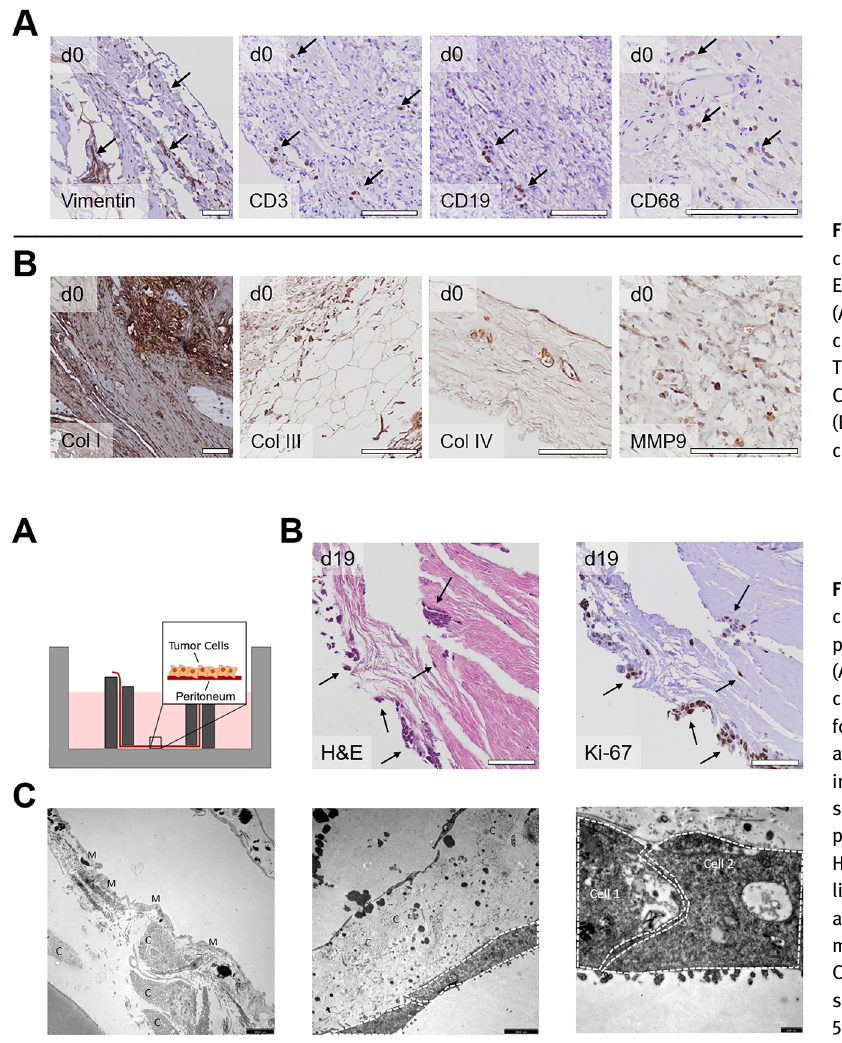
Figure 2: Immunohistochemical characterization of peritoneal cells and ECM components.